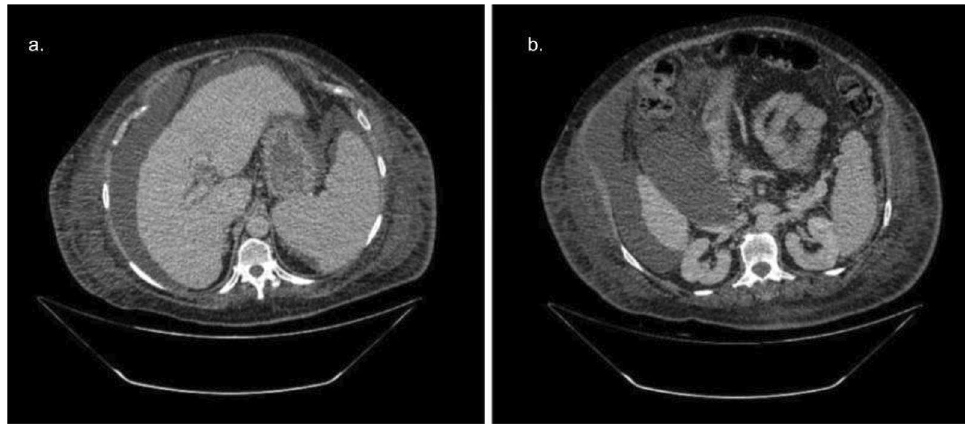
Figure 9. Two slices from the delayed phase incorrectly classified as portal phase. In general, in the delayed phase, we notice contrast being excreted in the urinary collecting system. In this case, despite being a delayed phase, no contrast was observed, probably due to low cardiac output or slow urinary function.